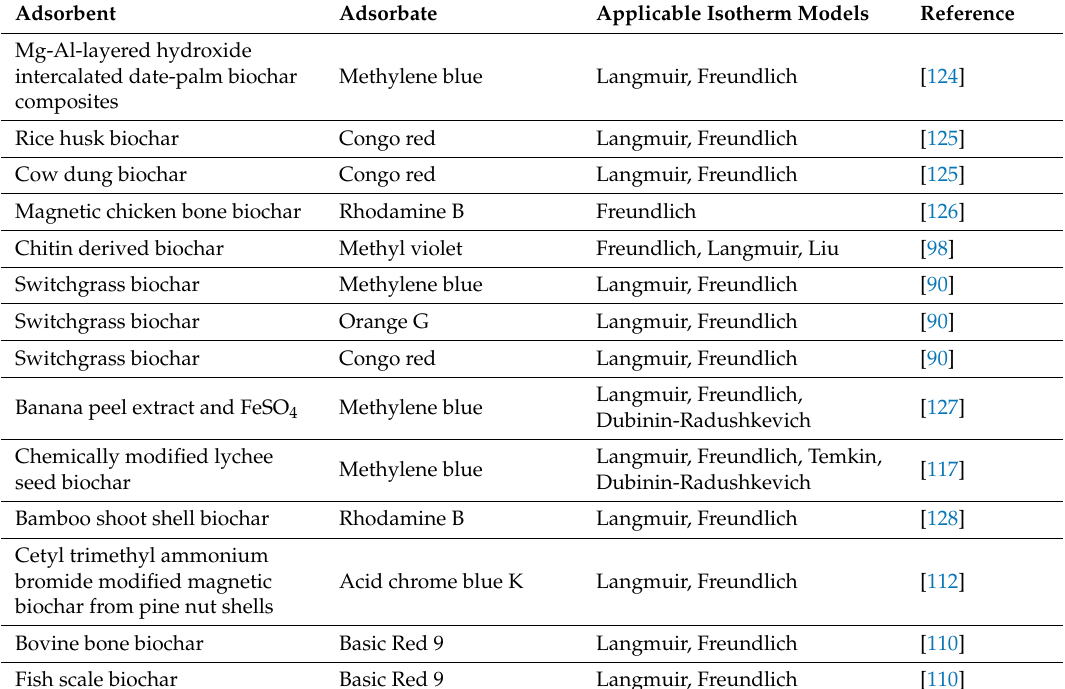
Table 3. Adsorption isotherm studies of di ff erent dyes onto